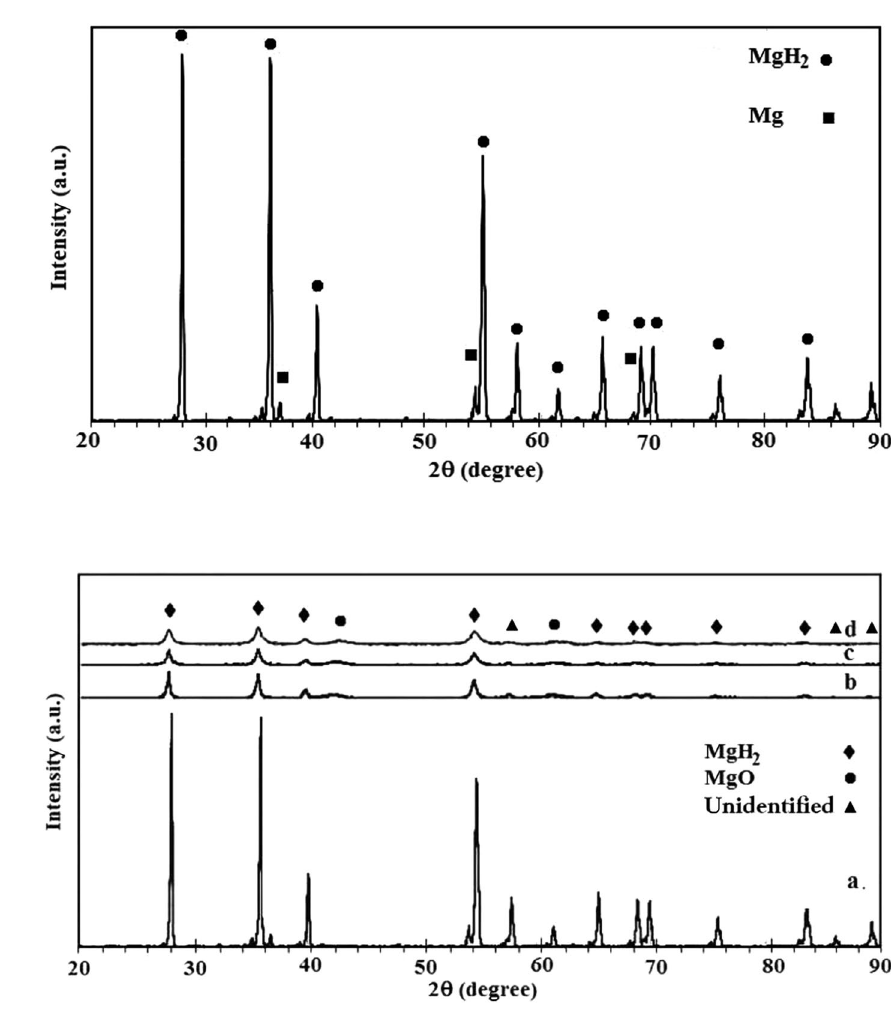
Table 1 Mean crystallite size and lattice strain of the ball-milled MgH 2 Time of ball-milling